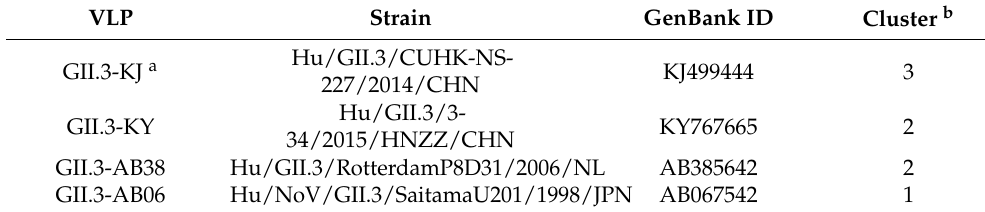
Table 1. A summary of all the GII.3 VLPs used in this study. VLP Strain GenBank